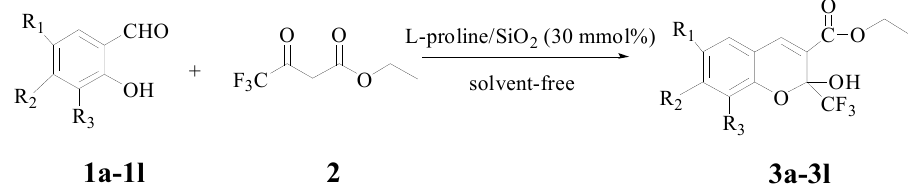
Scheme 2. Solvent-free synthesis of compound 3a – l .